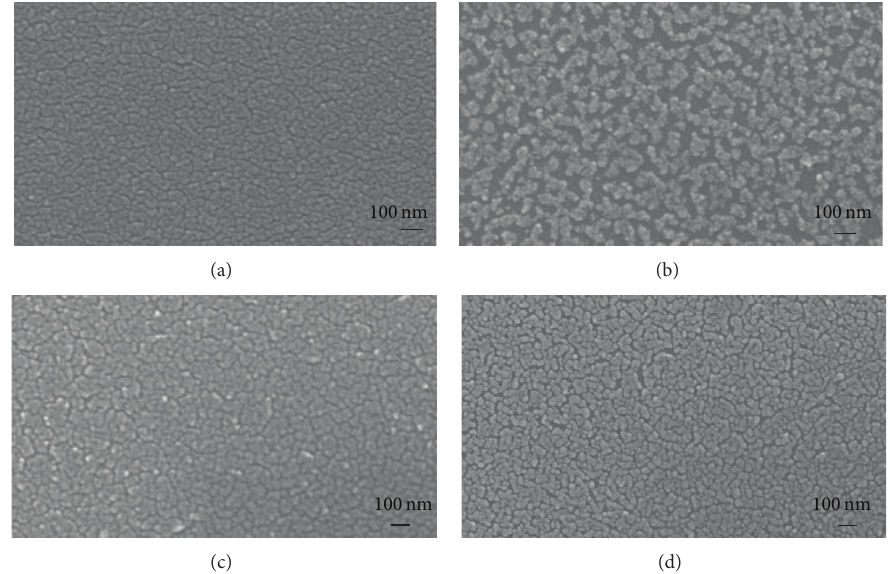
Figure 8: SEM images of Au thin films deposited in the presence of inorganic acids. Galvanic displacement is conducted for 3 min in 1.0mM HAuCl 4 solution containing (a) no acid, (b) 0.8 M HCl, (c) 4.6 M H 2 SO 4 , and (d) 3.3 M HF.